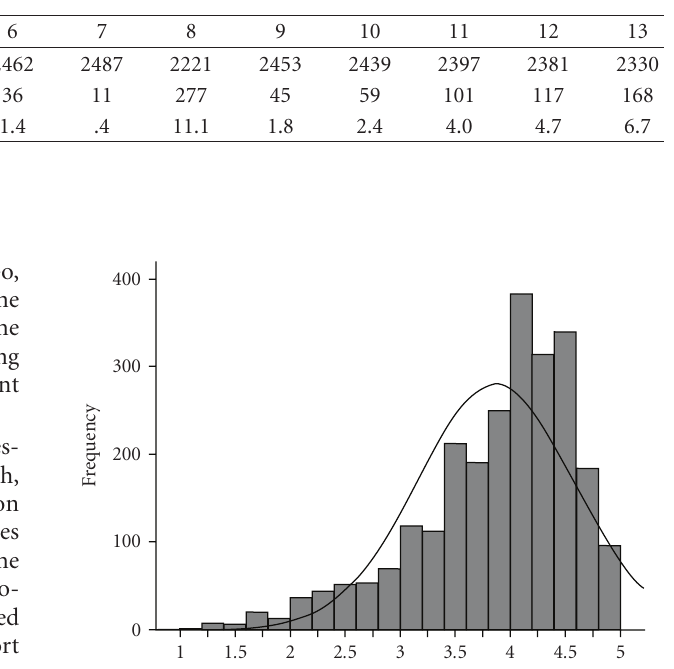
Table 6: Overview of missing values for each item (second version).